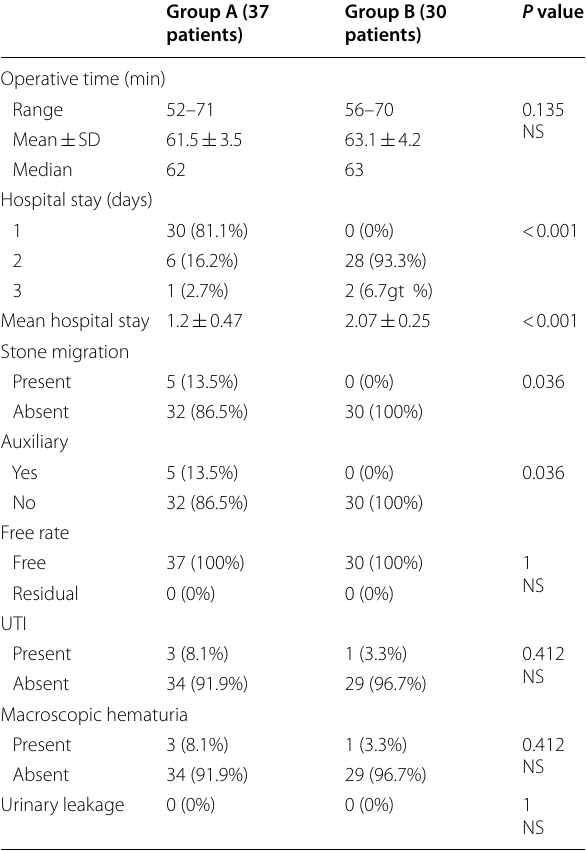
Table 2 Operative data and postoperative